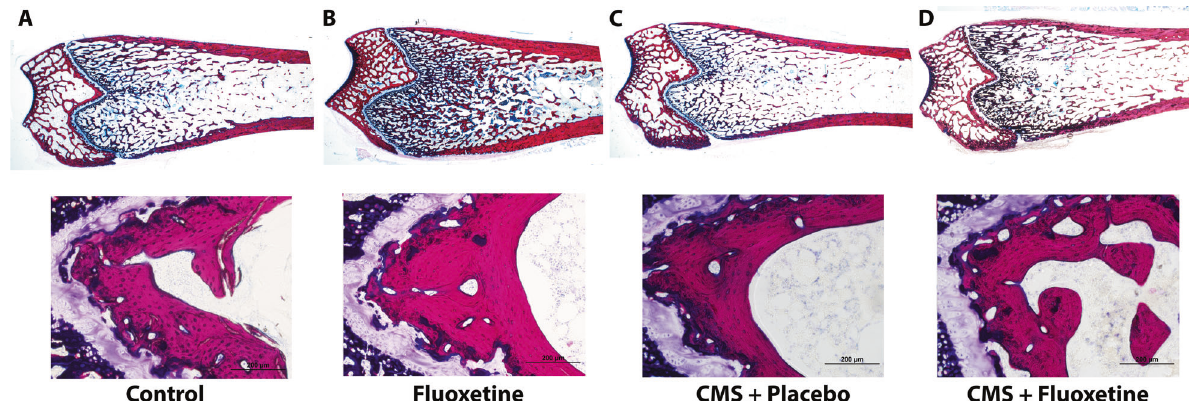
Fig. 5 Representative histological sections (sagittal view) of bone femur specimens stained with basic fuchsin and counterstained with methylene blue. A Control, B Fluoxetine-only, C CMS + placebo and D CMS + fl uoxetine (Mag 40X) groups.